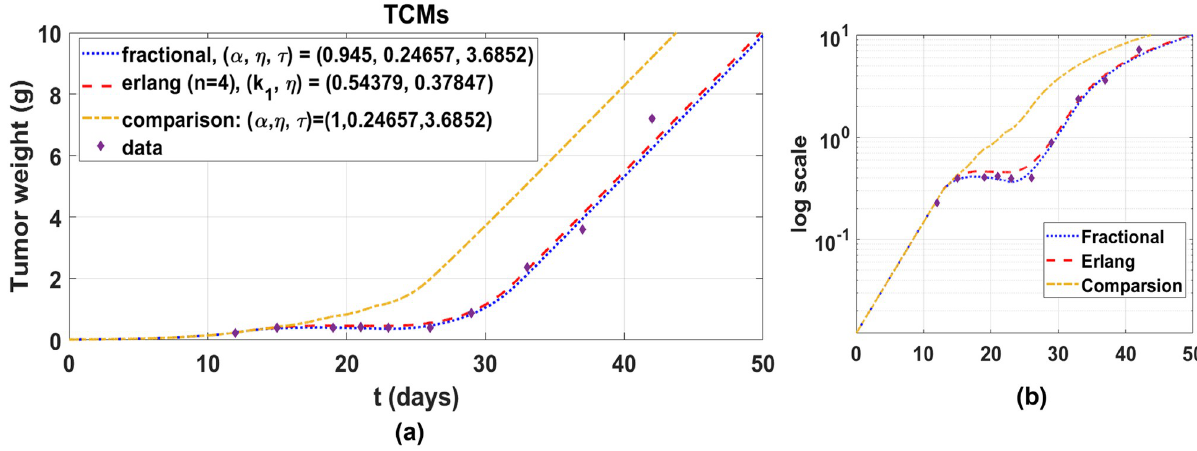
Fig 3. Comparison of Erlang and fractional TCMs. Scheduled drugs are administered ten times after day 13. The pre-specified number of damaged cells is n = 4. RMSE is calculated to find AIC. (a) We observe the delay effect of fractional order α , α = 1 (no delay). (b) Log-scale is used to compare data fit